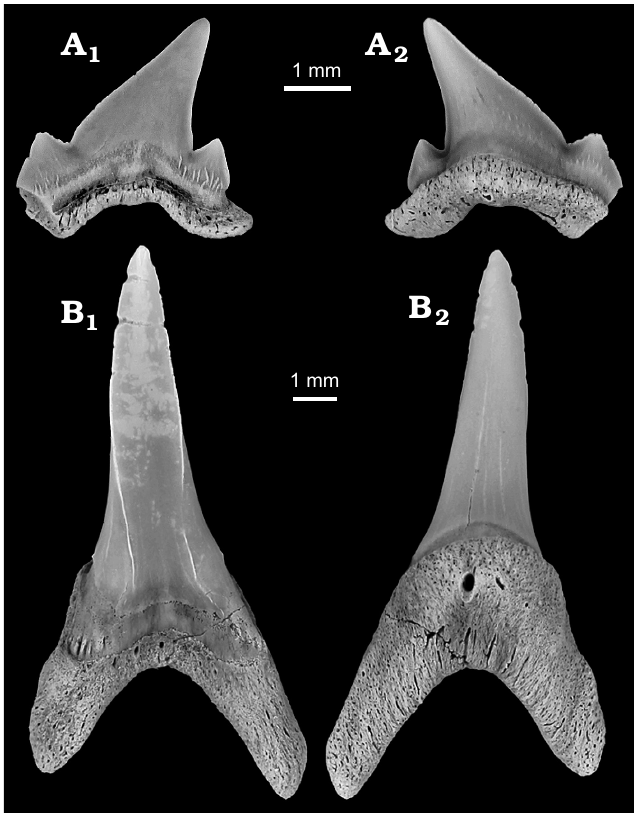
Fig. 3. Isolated, small juvenile teeth of Cardabiodon ricki Siverson, 1999 (WAM 13.6.1: lp7–9?) ( A ) and Cretoxyrhina agassizensis (Underwood and Cumbaa, 2010) (WAM 13.6.2: a2?) ( B ) from the basal (0.1 m) of the Haycock Marl, Pillawarra Plateau, Western Australia, late Cenomanian or early Turonian. In labial (A , A ) and lingual (B , B ) 1 2 1 2